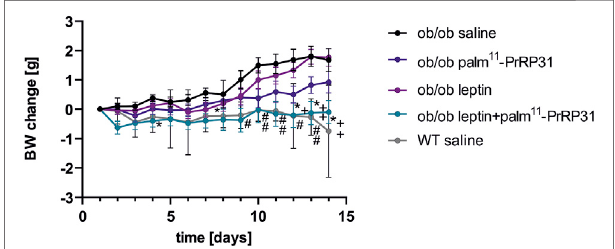
FIGURE 3 | Chronic effect of palm 11 -PrRP31, leptin and their combination on BW change in ob/ob mice modi fi ed from (Korinkova et al., 2020) Mice were treated fo 2 weeks. Data are presented as means ± S.E.M. Statistical analysis was performed by Two-way ANOVA with Tukey post hoc test, signi fi cance is # < 0.05, ## < 0.01 ob/ob saline vs wild type (WT) saline, p < 0.05, ** < 0.01 ob/ob leptin + palm 11 -PrRP31 vs ob/ob saline, + <